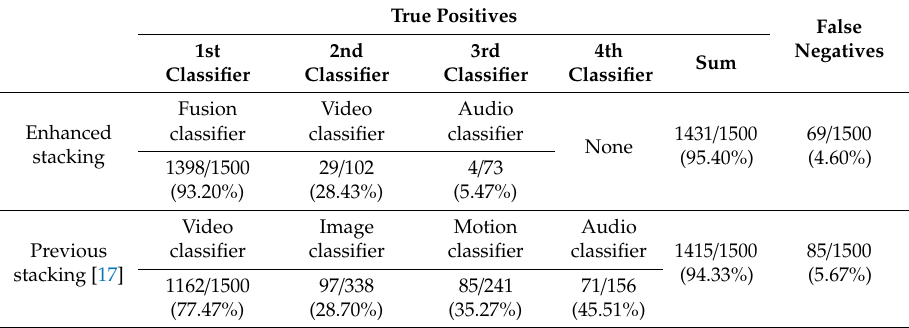
Table 4. Comparison of detection e ff ects of the component